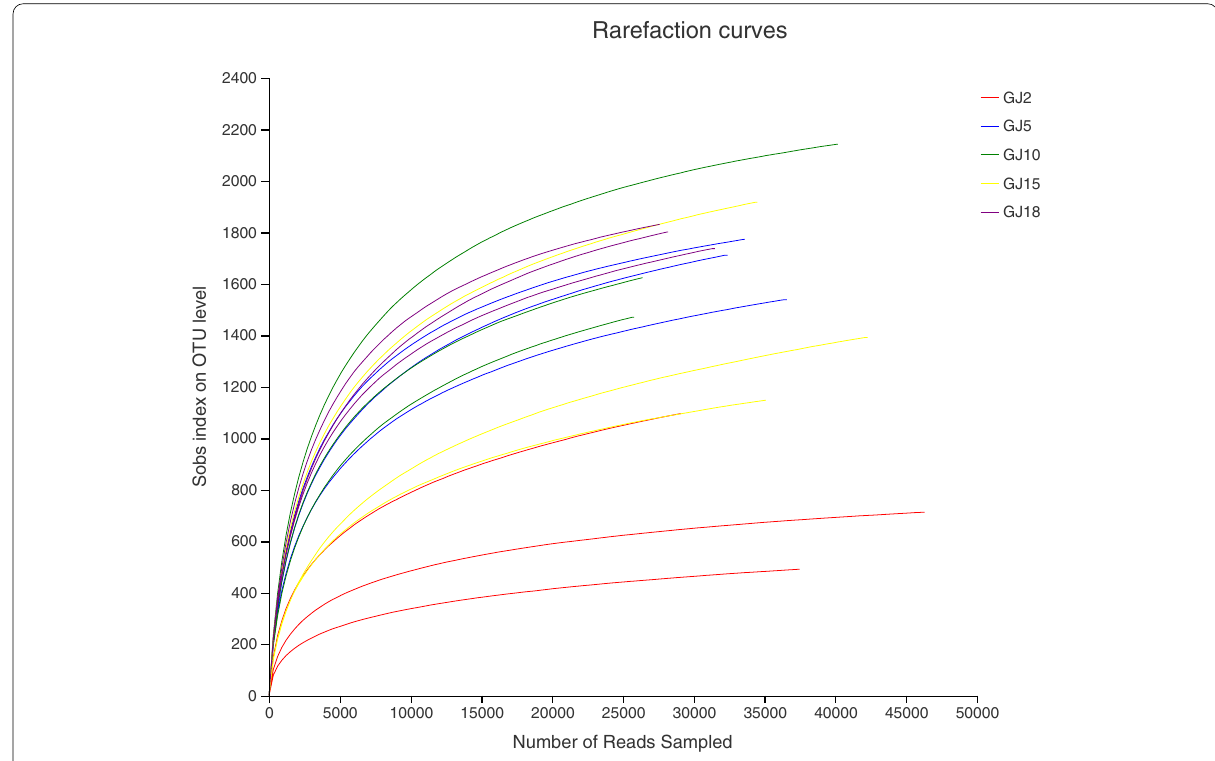
Fig. 1 Rarefaction curves. GJ2‑18 were the 2–18 year‑old citrus